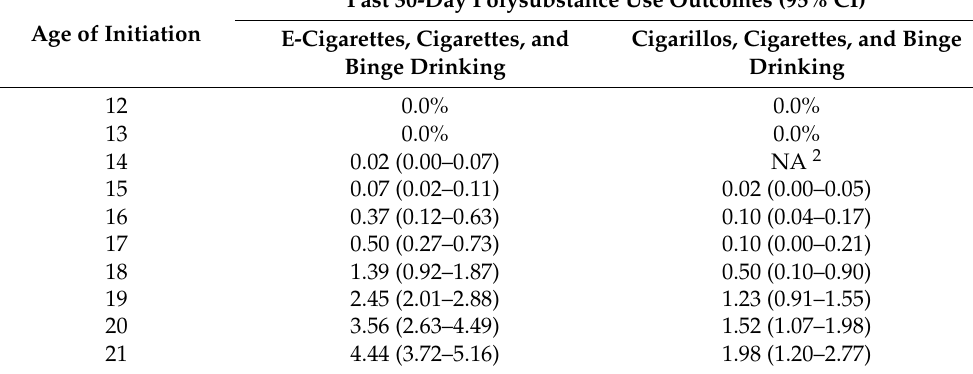
Table 2. Estimated hazard functions 1 (with 95% confidence intervals) of the age of initiation of each past 30-day polysubstance use outcome in PATH ¥ youth